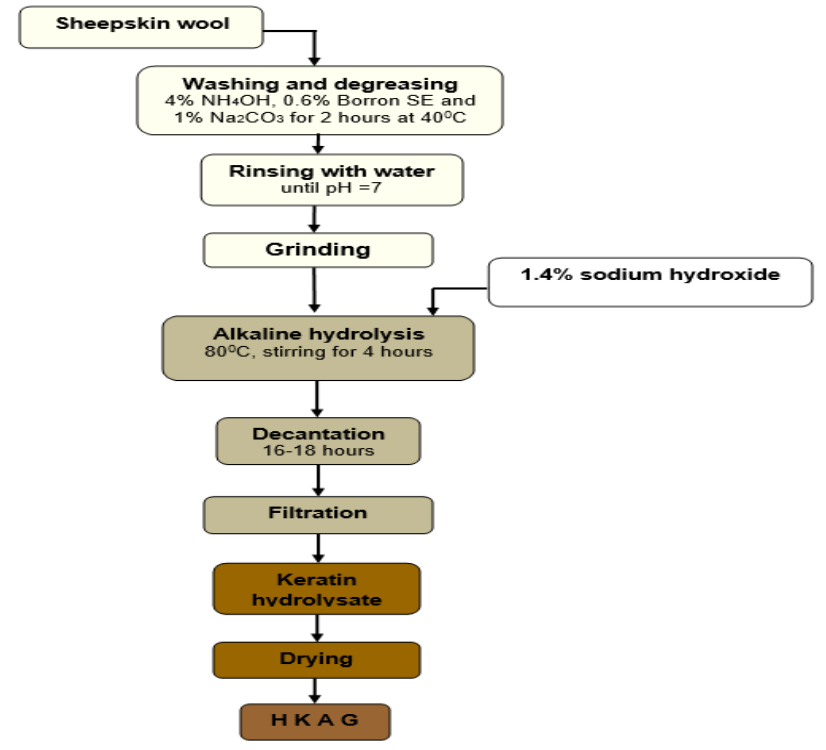
Figure 3. The flowchart of keratin hydrolysate preparation .